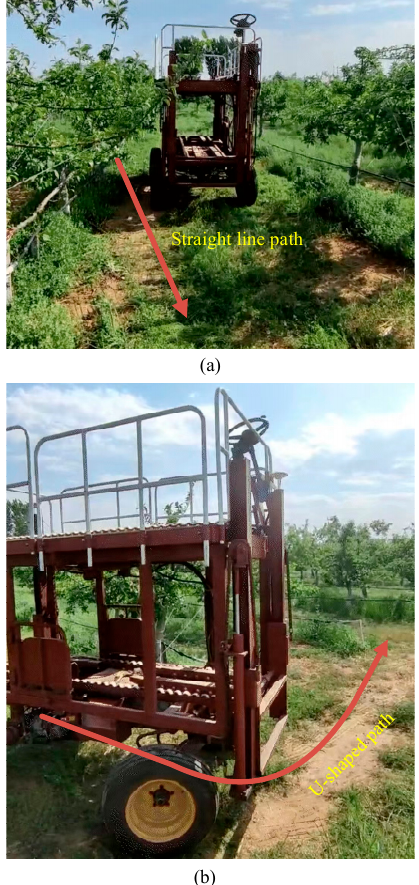
Figure 22. Automatic navigation tests. ( a ) Straight-line path navigation test. ( b ) U-shaped path navigation test.